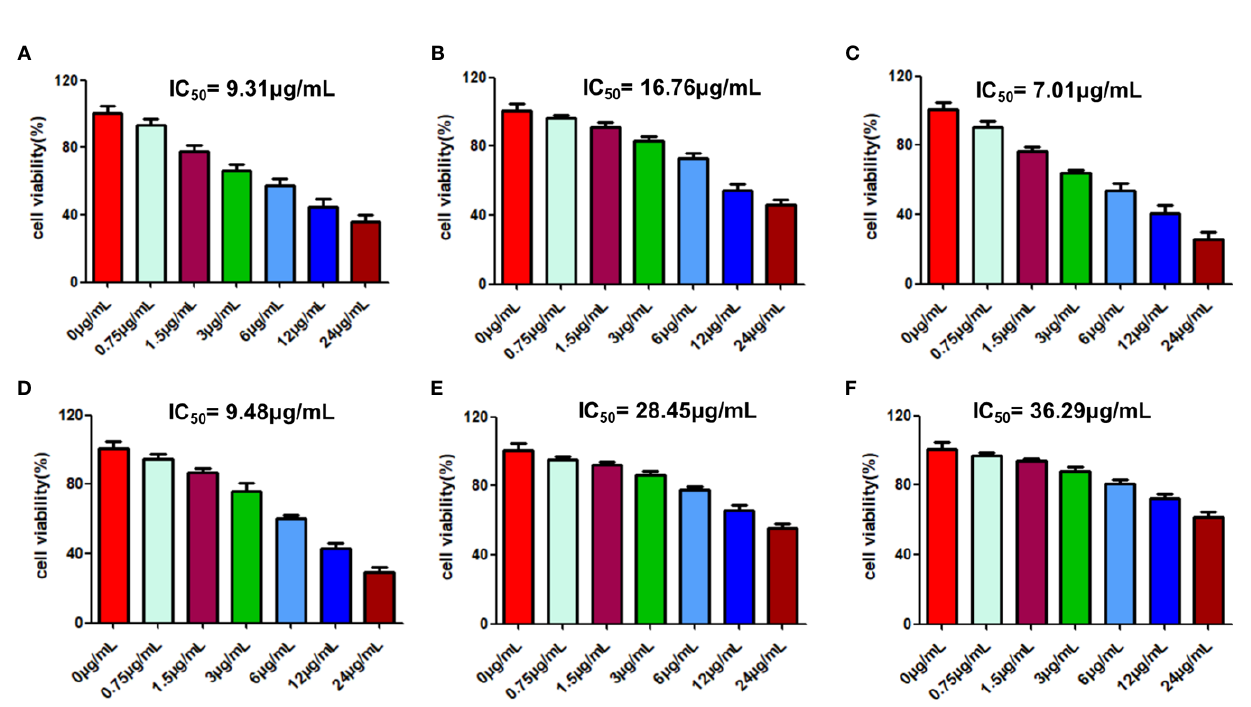
FIGURE 10 | Cytotoxic effects of emodin (A) , resveratrol (B) , aloe-emodin (C) , rhein (D) , chrysophanol (E) , and physcion (F) on A549 cells. Cells were treated with the candidate drugs (0, 0.75, 1.5, 3.0, 6.0, 12, and 24 µg/mL) for 24 h. Finally, CCK-8 assays were carried out to detect the cytotoxic effects of candidate drugs. Each experiment was repeated three times individually. The IC 50 values were calculated for evauation of the cytotoxic effects of candidate